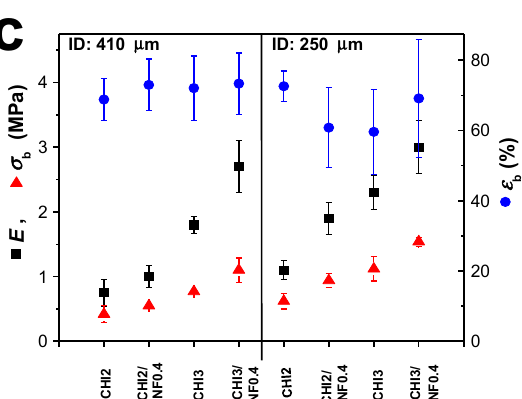
Figure 5. Stress–strain curves of uniaxially stretched printed hydrogel filaments of chitosan (CHI) alone and cellulose nanofiber (CNF) filled chitosan composites, for different CHI and CNF concentrations, by using conic extrusion needles with inner diameter (ID) of: ( a ) 410 µ m and ( b ) 250 µ m. ( c ) Young’s modulus (E), stress ( σ b ), and strain at break ( ε b ) achieved for the tensile tested filaments in ( a , b ), obtained with the two different extrusion needle IDs.